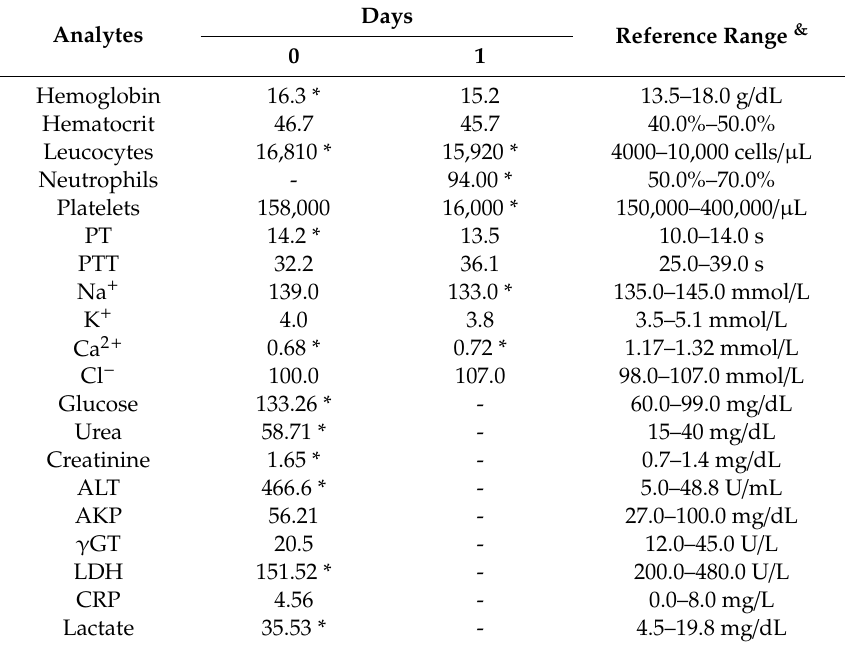
Table 1. Patient laboratory tests following rattlesnake bite.